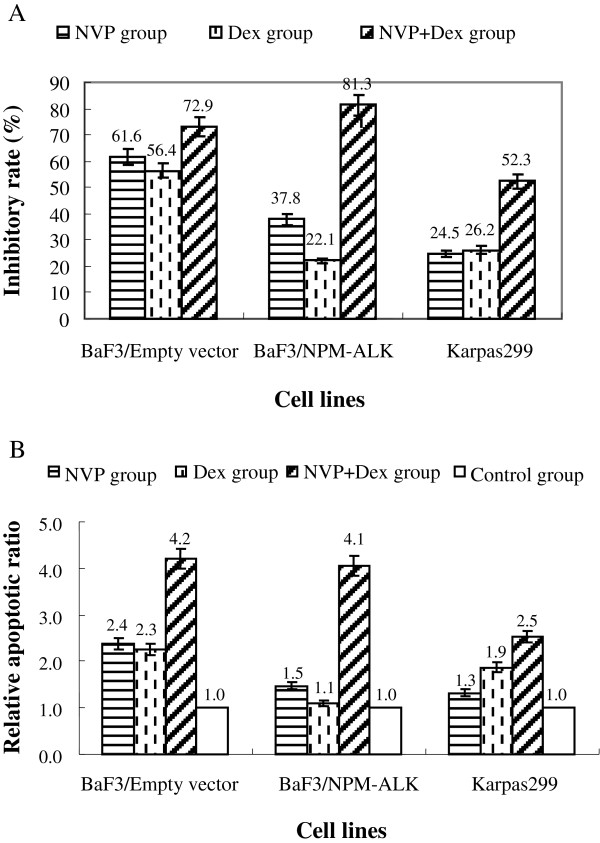
Targeting AKT/mTOR had a therapeutic significance on ALK + tumor cells. (A) Synergistic growth inhibition between the dual PI3K/mTOR inhibitor, NVP-BEZ235, and Dex in all cells, especially in BaF3/NPM-ALK. (B) A higher apoptosis rate in cells treated with NVP-BEZ235 and Dex together compared with single use of the drugs.